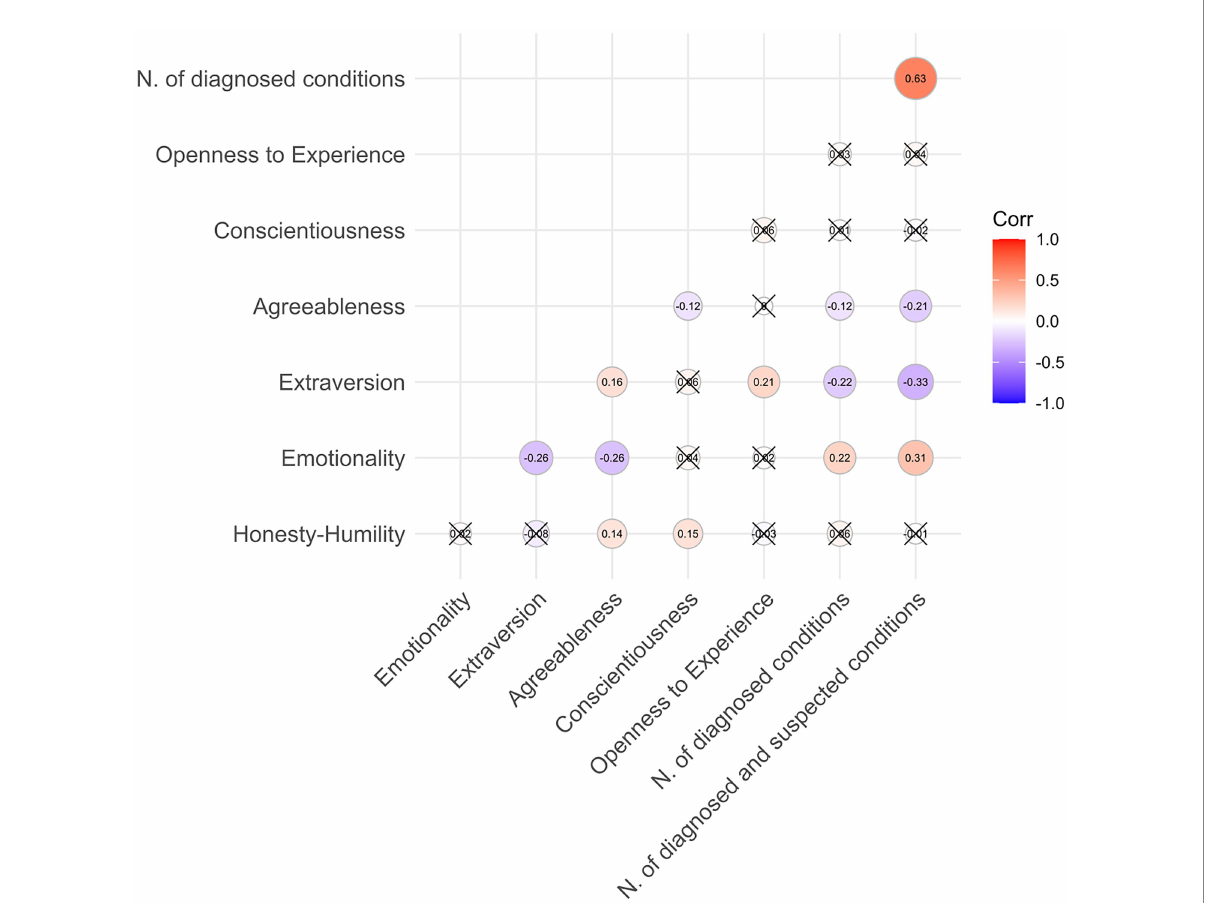
FIGURE 3 Correlation heatmap for bivariate Spearman correlations of the number of physiological and psychological health conditions and the six HEXACO personality